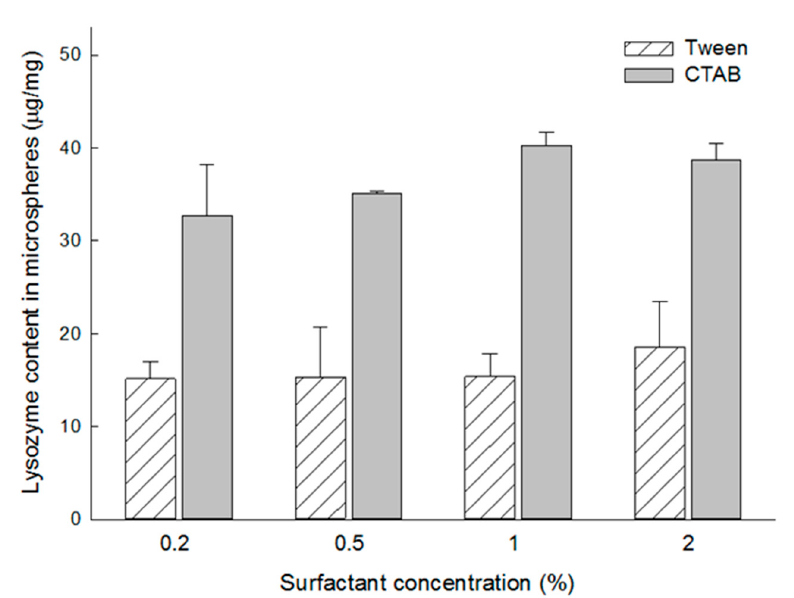
Figure 7. Effect of surfactant type upon lysozyme loading in dried microspheres prepared using 7 mL of the ammonia solution. In terms of lysozyme loading efficiency, CTAB shows a superior functionality than Tween